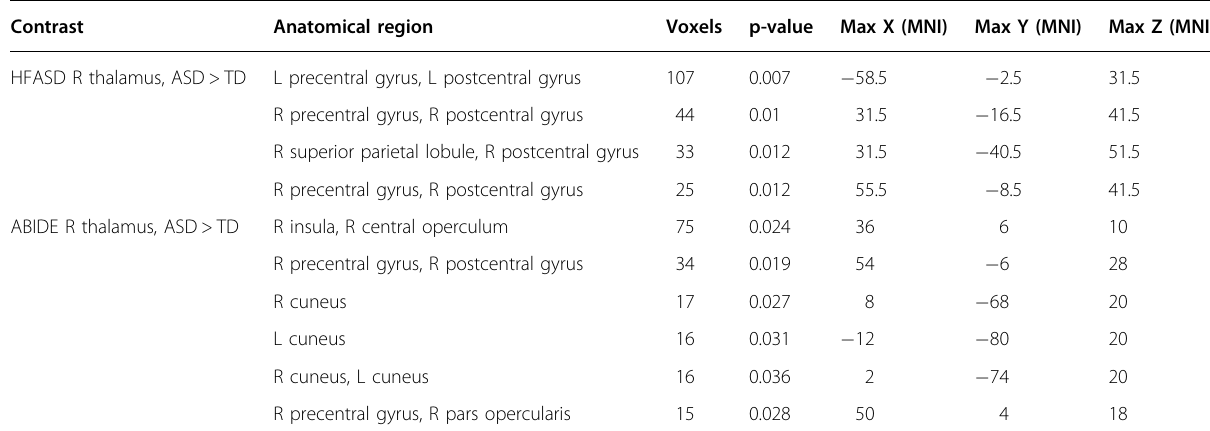
Table 3 Signi fi cant clusters found in seed connectivity analysis. Contrast